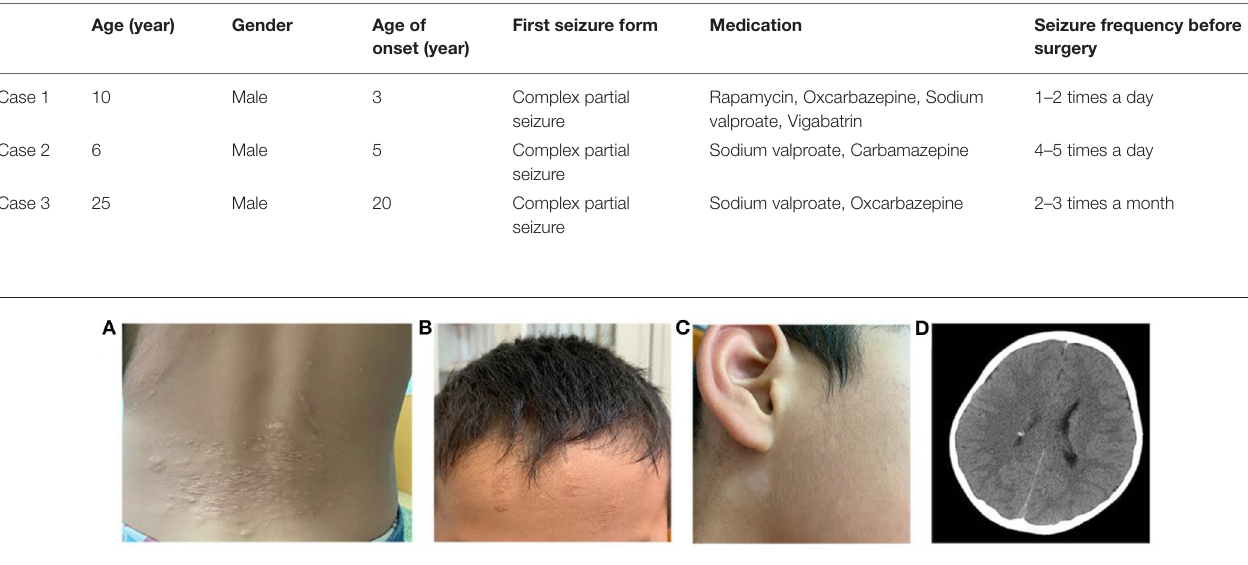
FIGURE 1 | Clinical manifestations of TSC. (A) Shagreen patch at the waist of case 1. (B) Ffibrous cephalic plaque of case 2. (C) Hypomelanotic macule in the face of case 2. (D) A nodular dense shadow in the lateral wall of the right lateral ventricle in cranial CT of case 2, considered as a subependymal nodule.